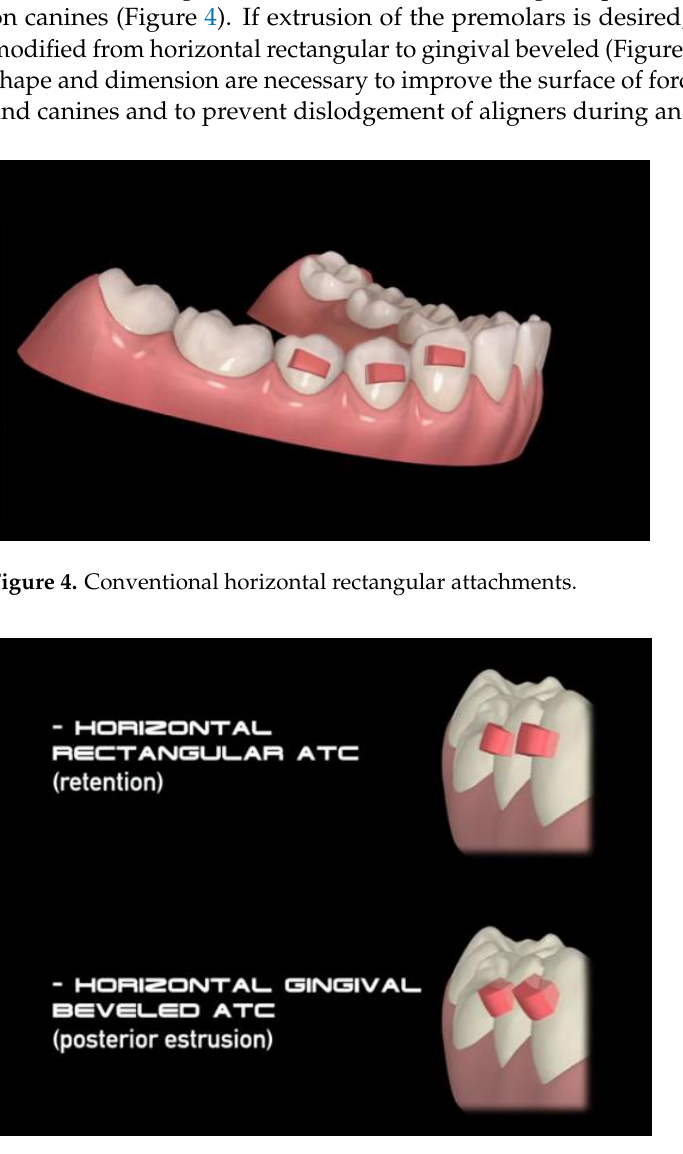
Figure 6. Working setup in a deep bite: ( A ) deep curve of Spee; ( B ) reverse curve of Spee archwire; ( C ) overengineered setup. A